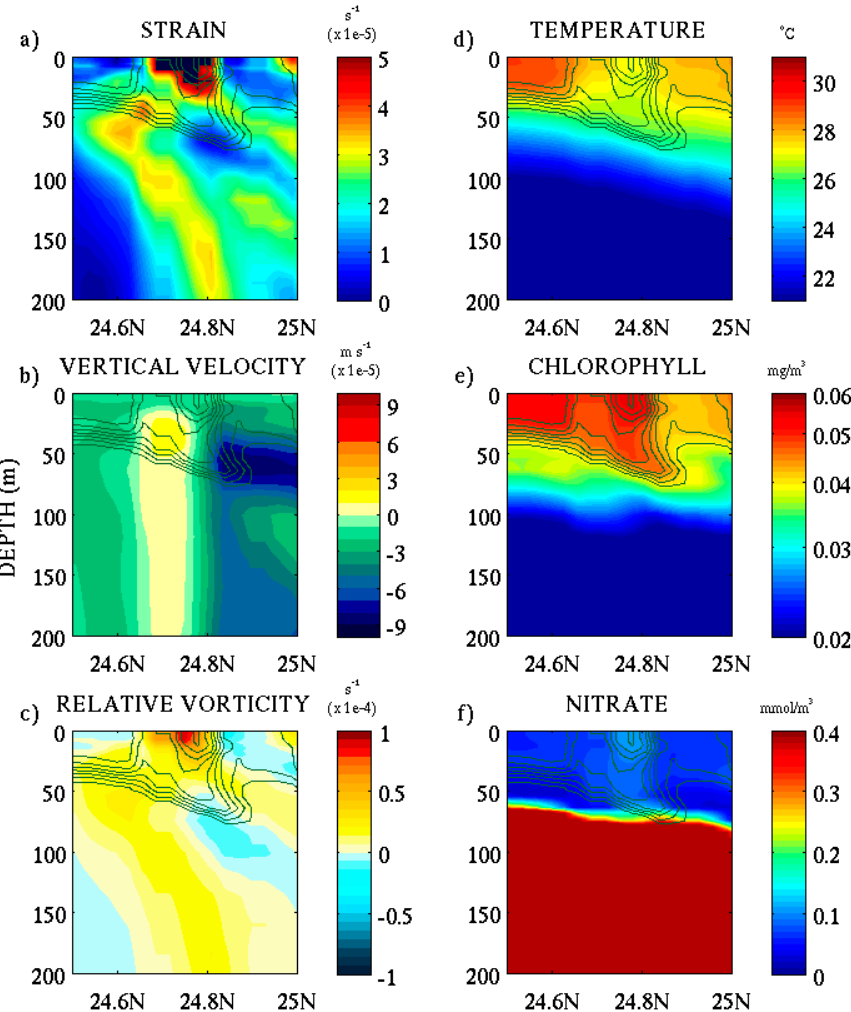
Figure 6. Simulated filament cross-section view (~89.6 ◦ W), outer filament edge 20 September 2004: ( a ) strain rate (s − 1 ); ( b ) vertical velocities (m s − 1 ); ( c ) relative vorticity (s − 1 ); ( d ) temperature ( ◦ C); ( e ) chlorophyll (mg m − 3 ) logarithmic scale; ( f ) nitrate (mmol N m − 3 ). Chlorophyll concentration contours are overlain on each panel, depth axis is down to 200 m.